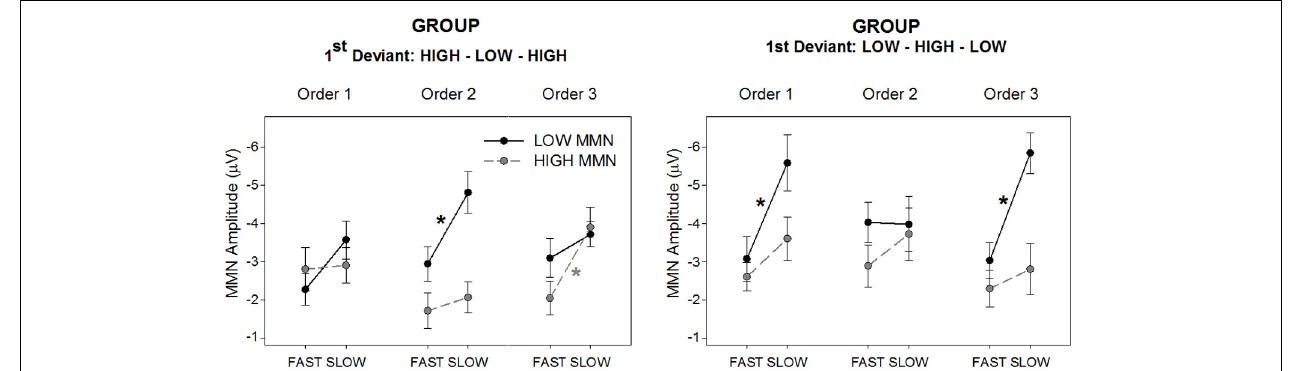
FIGURE 2 | Mean MMN amplitude for deviant high (gray/broken lines; “HIGH MMN”) and low (black full lines; “LOW MMN”) pitched tones, separately for the group hearing sequences with the High-Low-High 1st deviant order (left panel) and Low-High-Low 1st deviant order (right panel). The figure illustrates the MMN amplitude